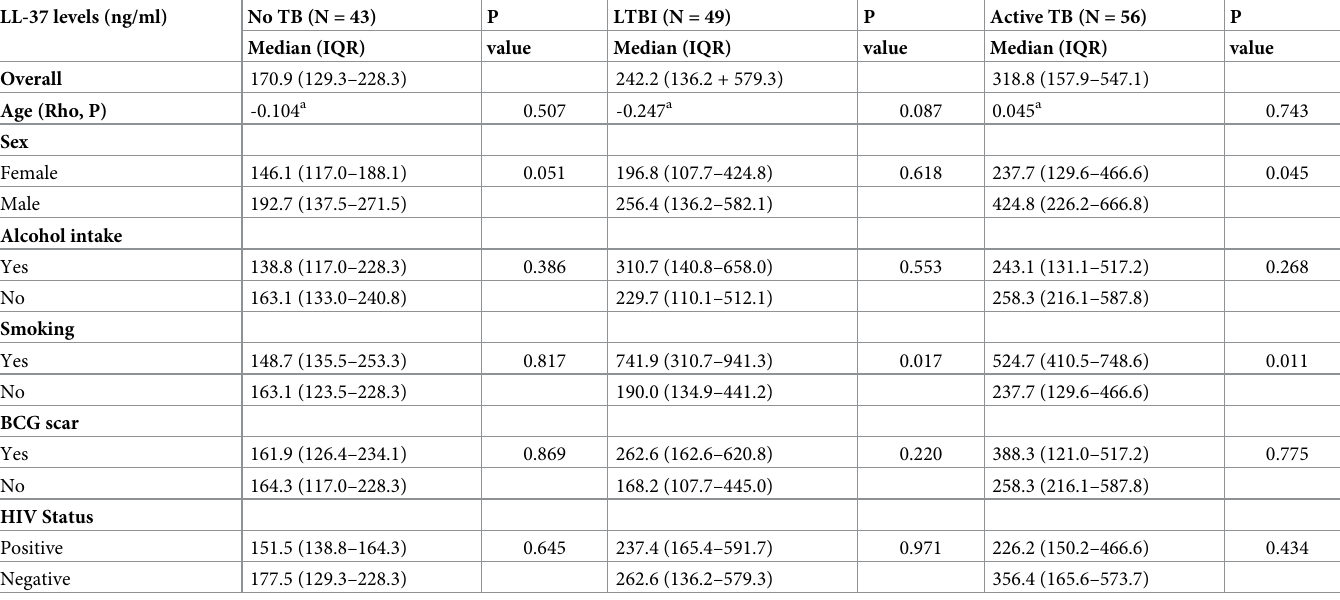
Table 4. Bivariate analysis of LL-37 levels and categorical variables in active TB patients, Latent TB individuals, and those without TB infection. LL-37 levels